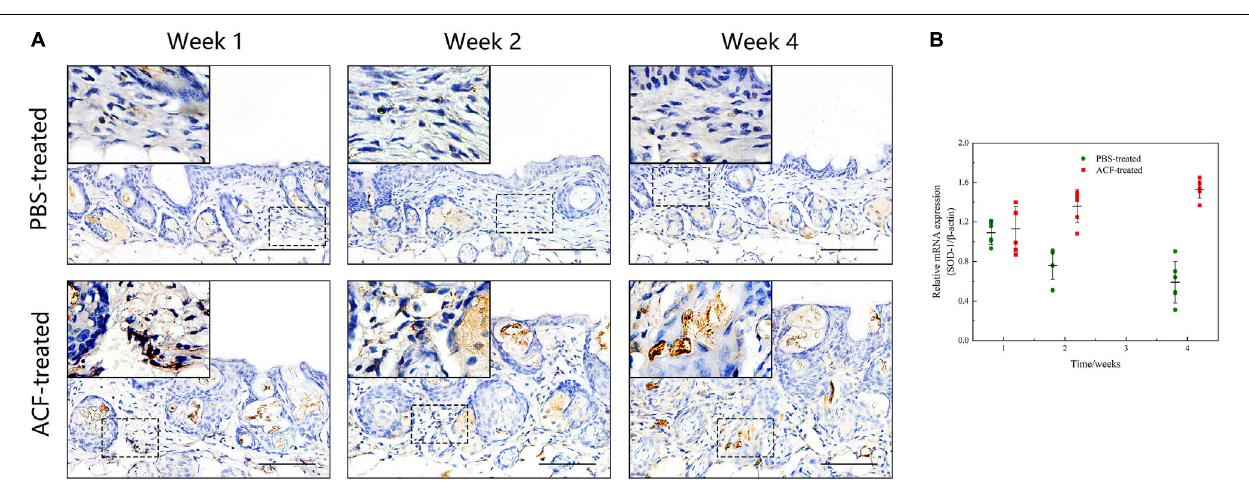
FIGURE 12 | The expression of SOD-1 of mouse skin samples of ACF-treated group and control group. (A) The expression of antioxidant enzyme SOD-1 was detected in both the ACF-treated and control groups at each time point. (B) Quantitative reverse transcription PCR analysis of the SOD-1 expression in the dermis of both groups. The expression of SOD-1 was higher in the ACF-treated group than in the control group at weeks 2–4. P (week 1) = 0.707, F (week 1) = 0.164; P (week 2) = 5.283E-05, F (week 2) = 0.747; P (week 4) = 1.253E-06, F (week 4) = 0.228. Scale bar = 100 µ